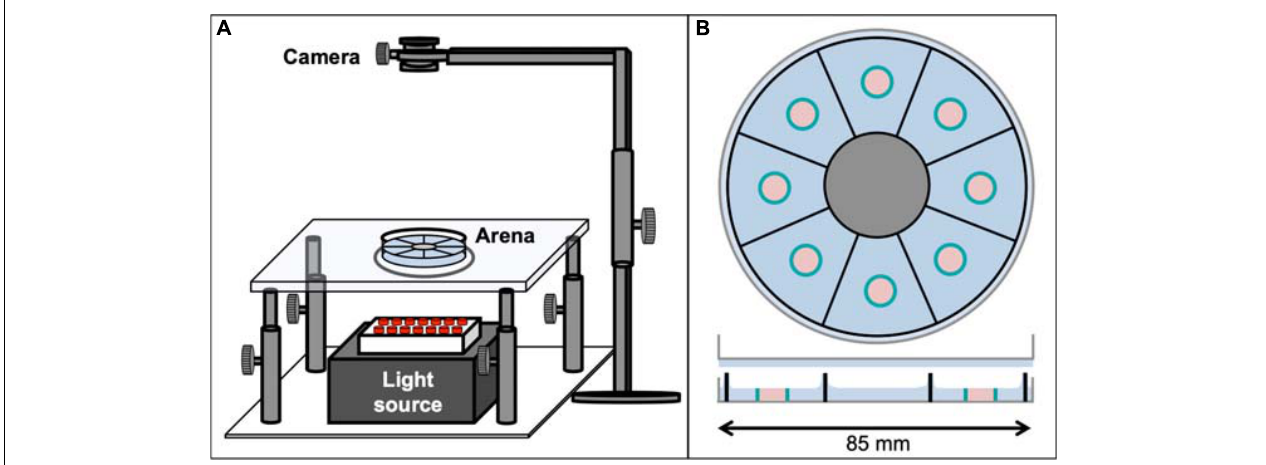
FIGURE 1 | The Panopticon. (A) Entire recording setup for the Panopticon. The whole assay platform has an infrared light source placed in the bottom (grey box with red LEDs), on top of which is a height-adjustable transparent glass platform with a small circular plastic layer acting as diffusor. The arena itself is placed on this platform, positioned precisely in line with the light source, the diffusor and the recording camera fitted on top with a stable holder. (B) Top view of Panopticon, sagittal view below. The arena consists of eight visually separated sectors, as indicated by sector-dividing walls of the 3D printed inset (black), which sits in substrate (blue) inside a Petri dish lid (grey). Another Petri dish lid with a layer of substrate closes the arena. Two configurations are used: (i) food patch arena with 1% agarose as substrate (depicted), which contains individual, centrally located food patch containers (teal blue) filled with 1% agarose with 200 mM sucrose (pastel pink) or (ii) omnipresent food arena without food patches, but 1% agarose with 200 mM sucrose as substrate (not